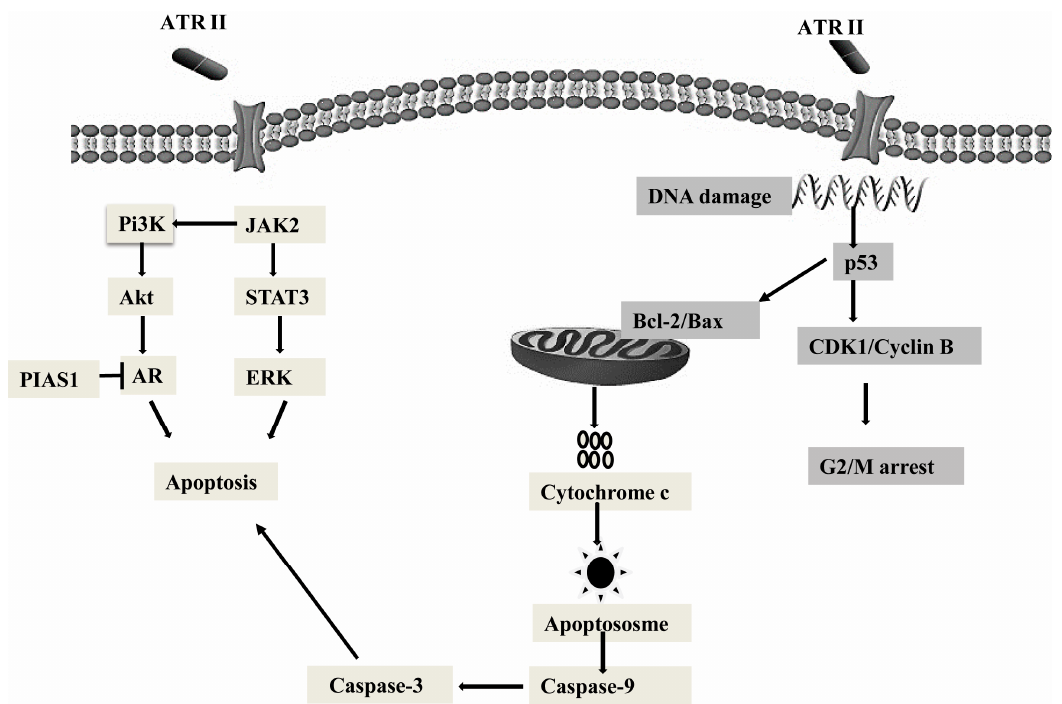
Figure 6. Hypothetical mechanism action of cancer cells. ATR II induces prostate cancer cells apoptosis through inhibition of JAK2/STAT3 signaling that promotes the inhibition of Pi3K/Akt as well as AR with overexpression of PIAS1, those were mainly drive through mitochondrial intrinsic